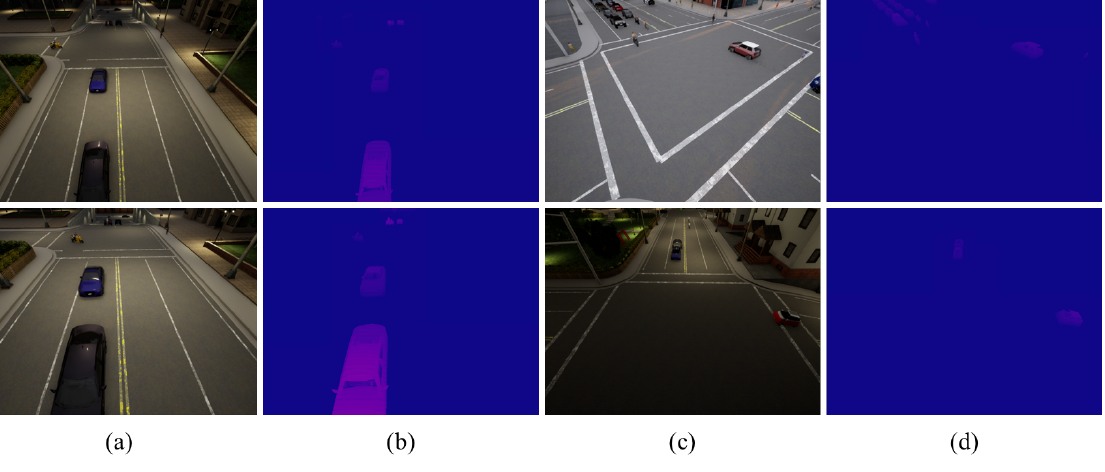
Figure 3. Generated height dataset using CARLA Simulator [23]. ( a , c ) represents the input color images, ( b , d ) is Ground Truth of each input color